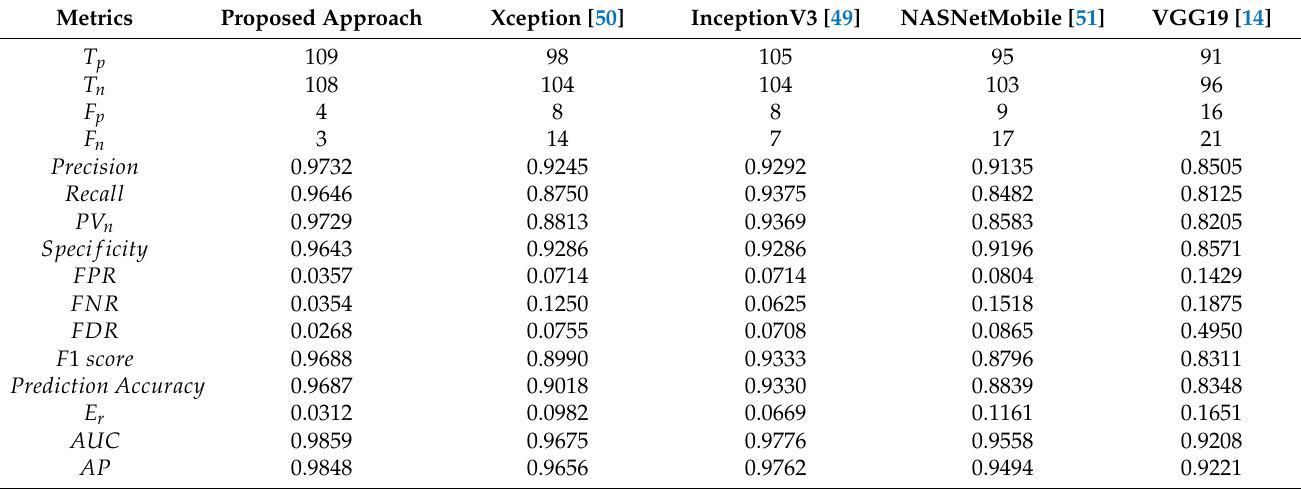
Table 3. Performance analysis.